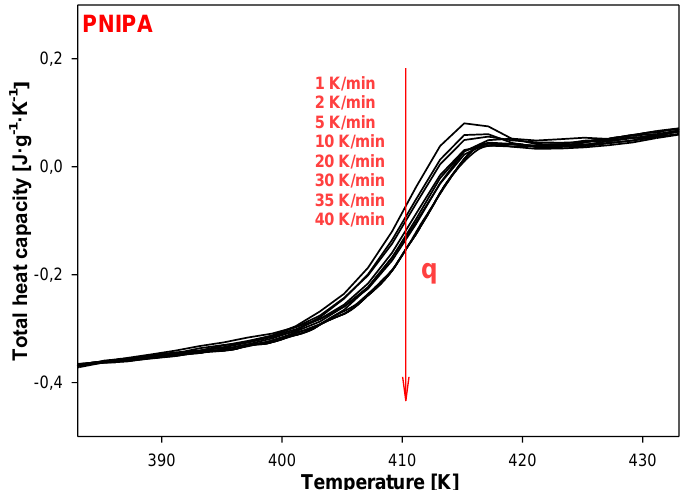
Figure 16. Non-isothermal aging of poly( N -isopropylacrylamide) with a different thermal history obtained based on variety of cooling rates in range of 1 K/min to 40 K/min. Total heat capacity was obtained based on heating scans by the temperature-modulated differential scanning calorimetry, TMDSC.